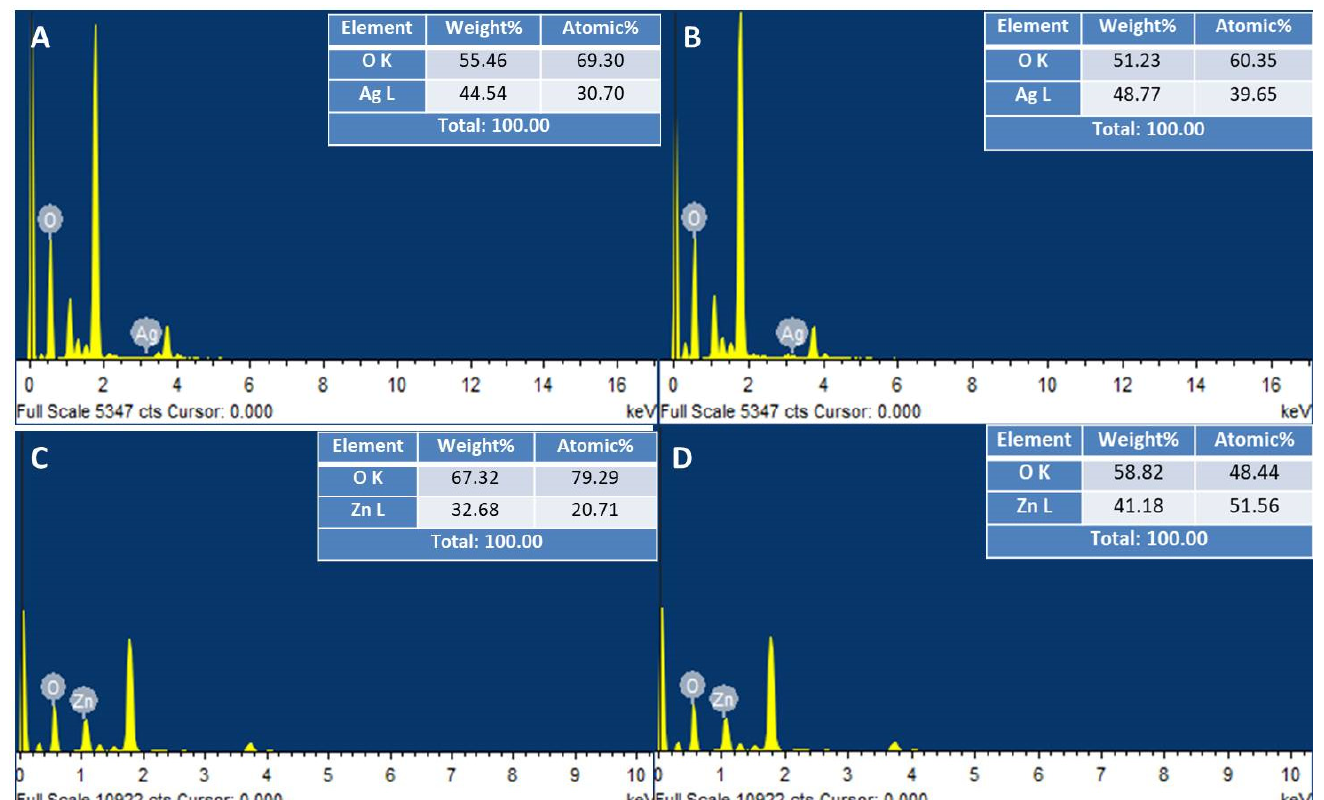
Figure 9. EDX analysis of monometallic NPs. ( A ) Control AgNPs. ( B ) UV-C mediated AgNPs. ( C ) Control ZnONPs. ( D ) UV-C mediated ZnONPs.